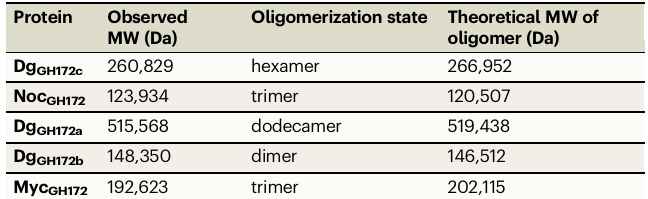
Table 2 | k cat / K M of GH172 enzymes for pNP- α - D -Ara f and AG Protein pNP- D -Ara f